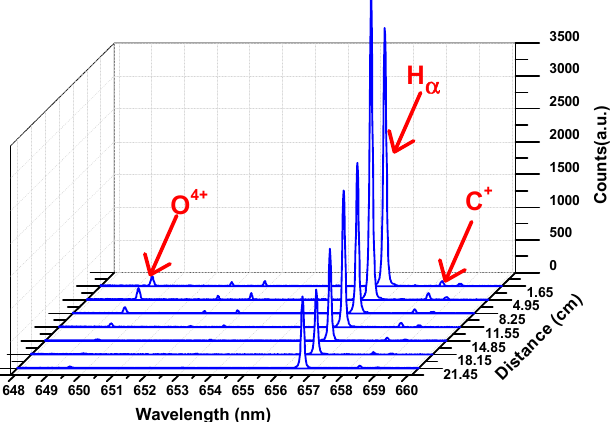
Figure 3. Space-resolved H α , C + , and O 4+ spectra for seven tracks corresponding to seven lines of sight (LoSs).